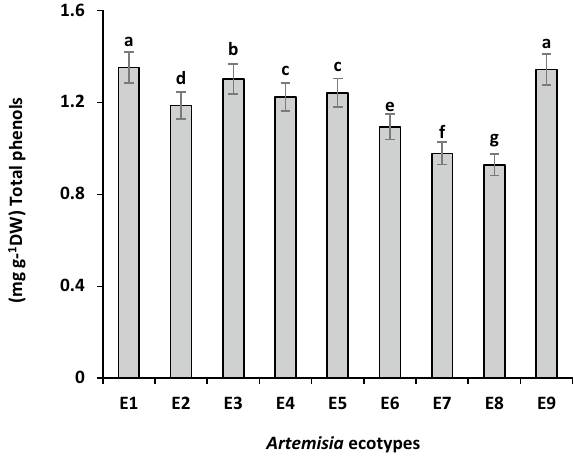
Figure 3. Comparison of mean total phenol ± standard error in different Artemisia ecotypes. E1: A.tournefortiana (Kerman province), E2: A.tournefortiana (North Khorasan province), E3: A.tournefortiana (West Azerbaijan province), E4: A.khorassanica (South Khorasan province), E5: A.khorassanica (North Khorasan province), E6: A.khorassanica (Semnan province), E7: A.haussknechtii (Kohgiluyeh and Boyer-Ahmad province), E8: A.haussknechtii (Isfahan province), E9: A.haussknechtii (Chaharmahal and Bakhtiari province).